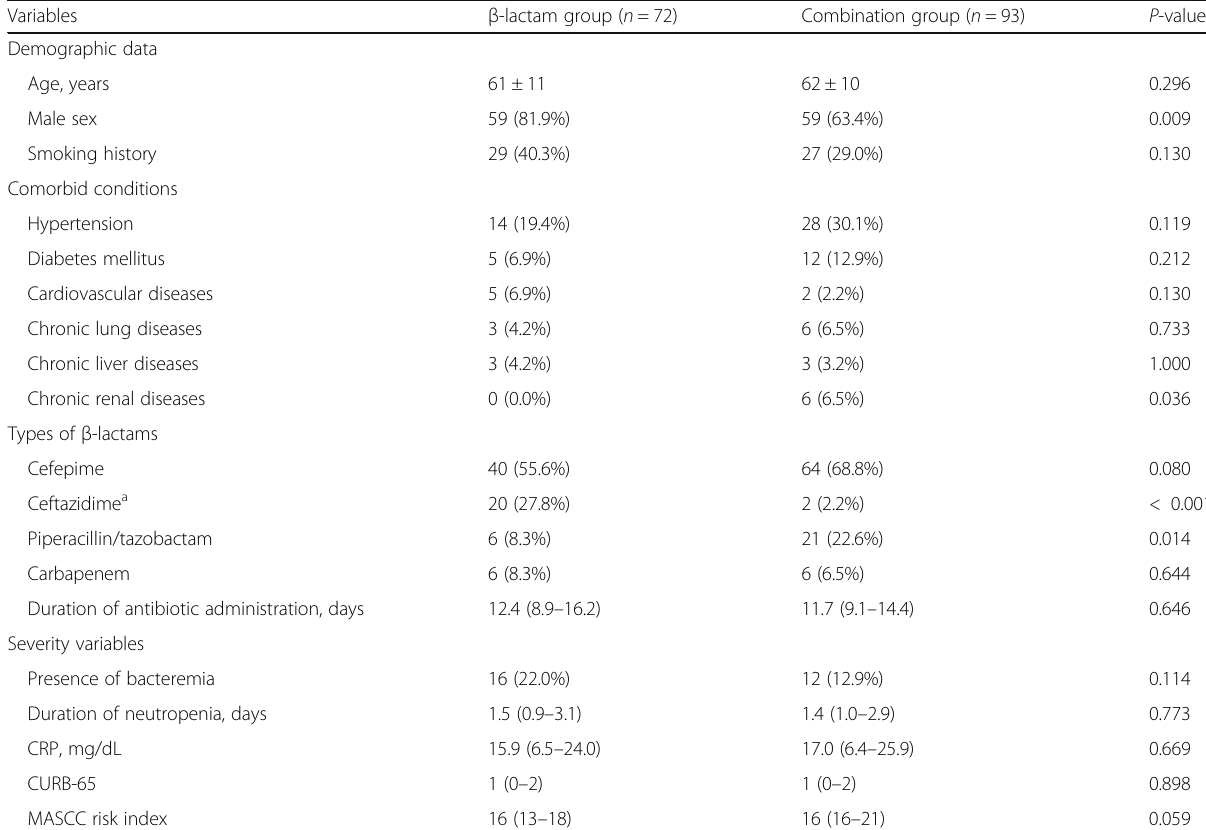
Table 1 Baseline characteristics, types of β -lactams, and severity of patients with neutropenic pneumonia